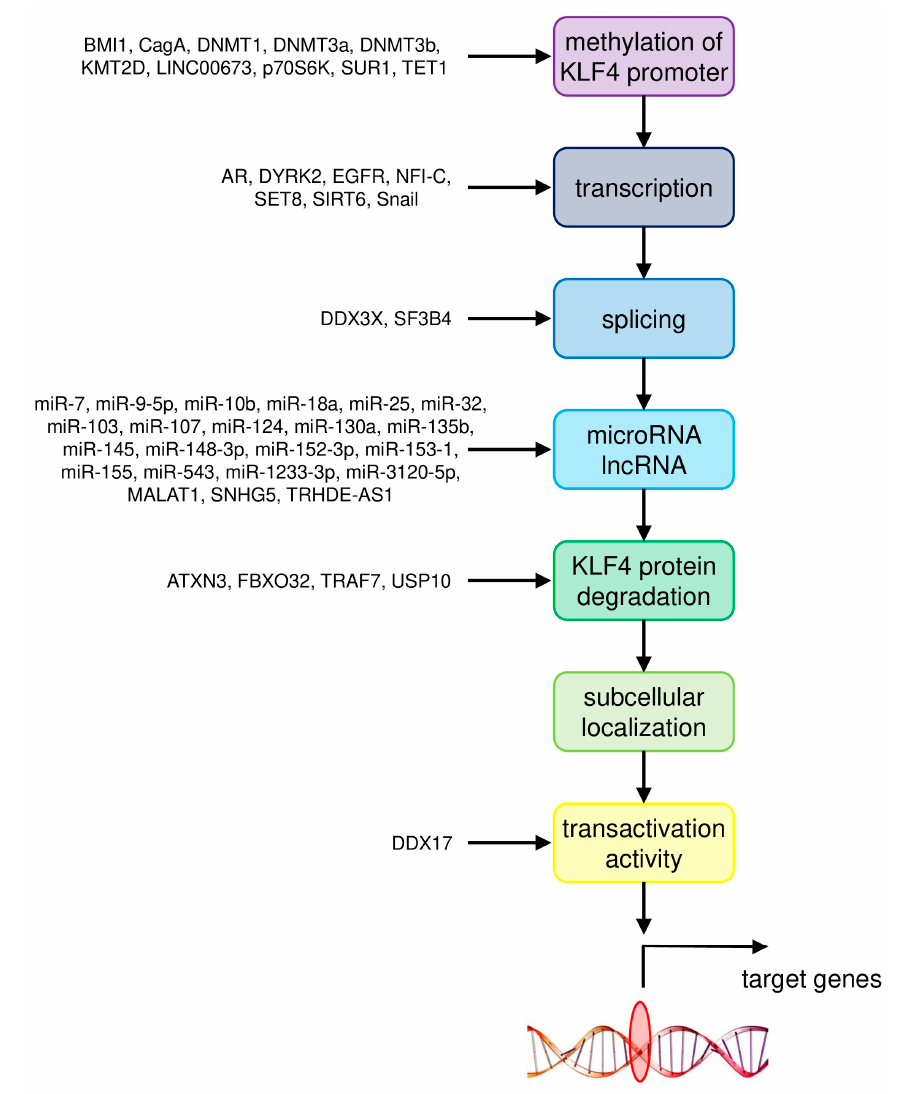
Figure 1. Summary of molecular mechanisms of regulation of KLF4 activity in the most common cancer types.